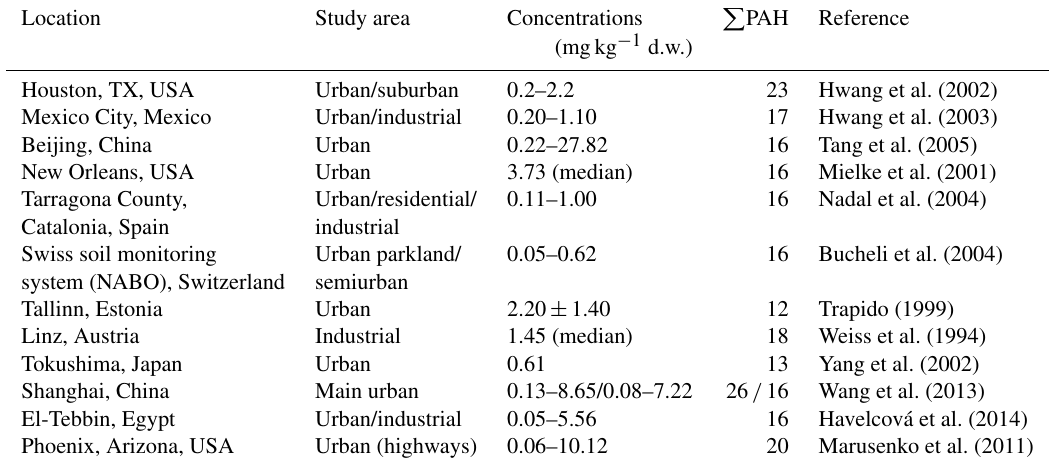
Table 4. Reported total concentrations of PAHs in urban soils (mgkg − 1 dry weight) from a number of studies.